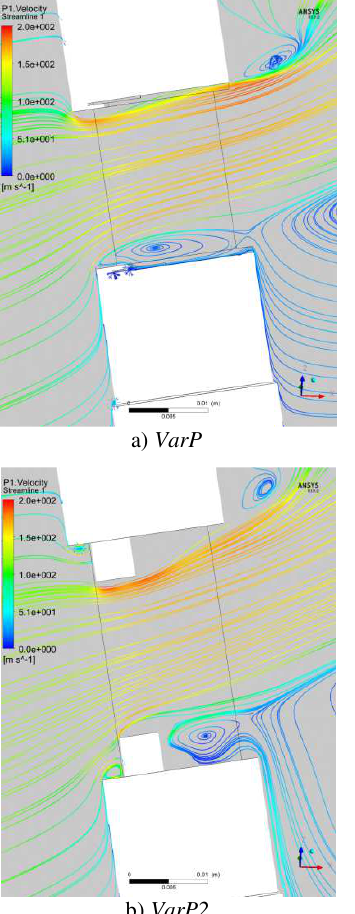
Fig. 9 . Surface streamline on a cross-section of the domain